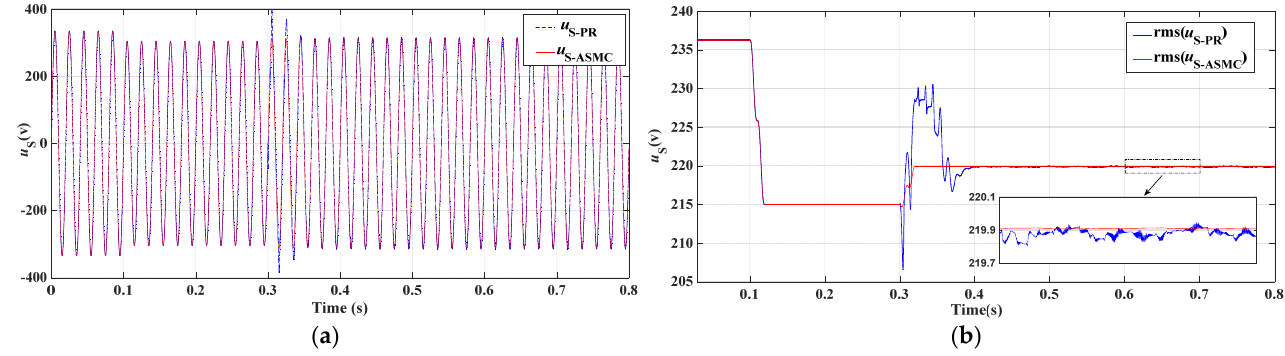
Figure 4. Comparison of u S under ASMC and PR control when the ES works in capacitive mode: ( a ) waveform comparison, ( b ) RMS comparison.